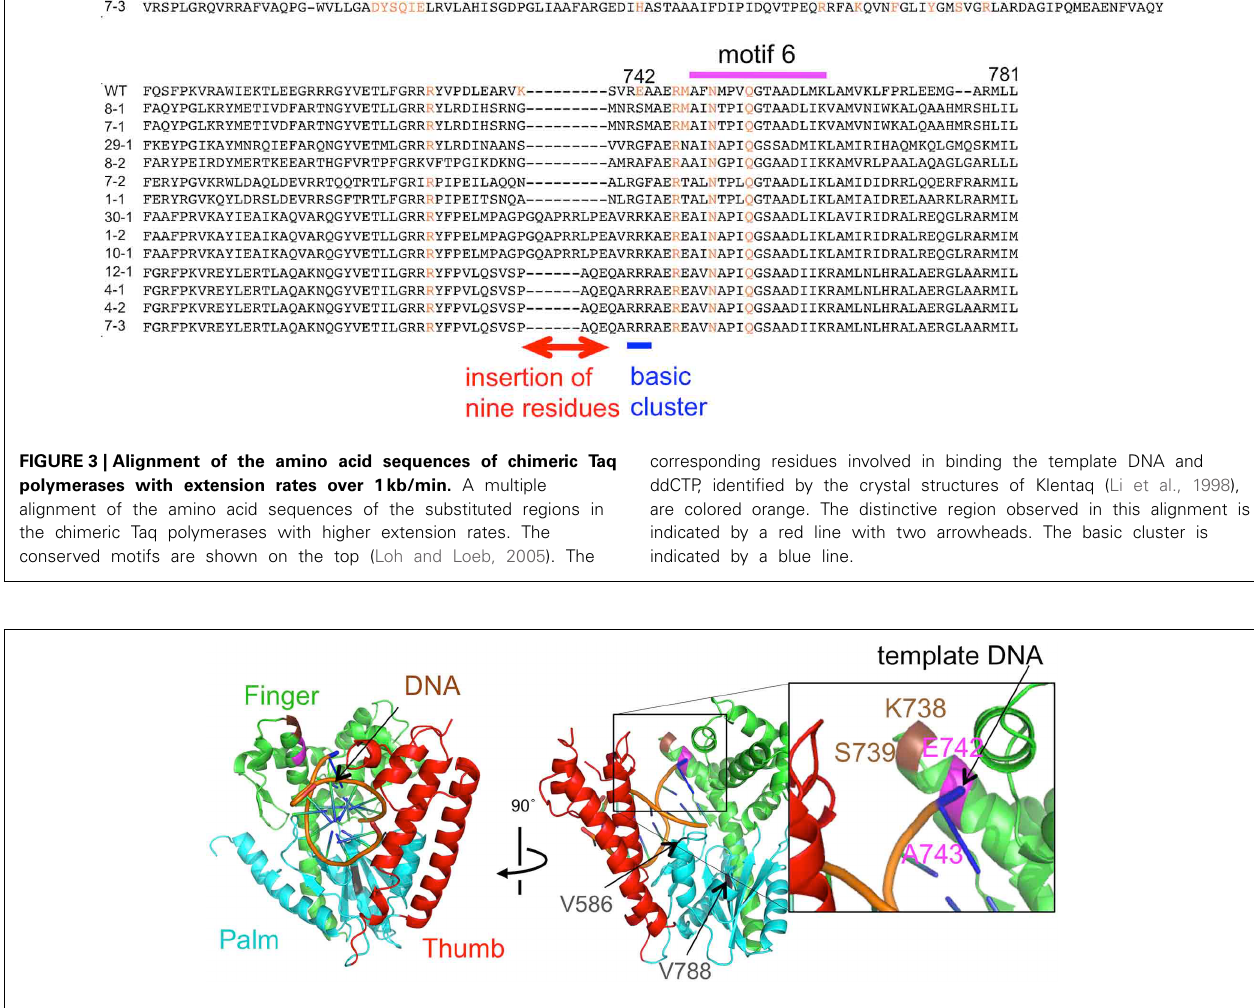
(backbones are colored orange). The residues E742 and A743 for the mutations are shown in magenta. The site, K738 and S739, where the interesting 9 amino acids were inserted was colored brown. The residues V586 and V788 corresponding to the junctions of the substitutions were shown in